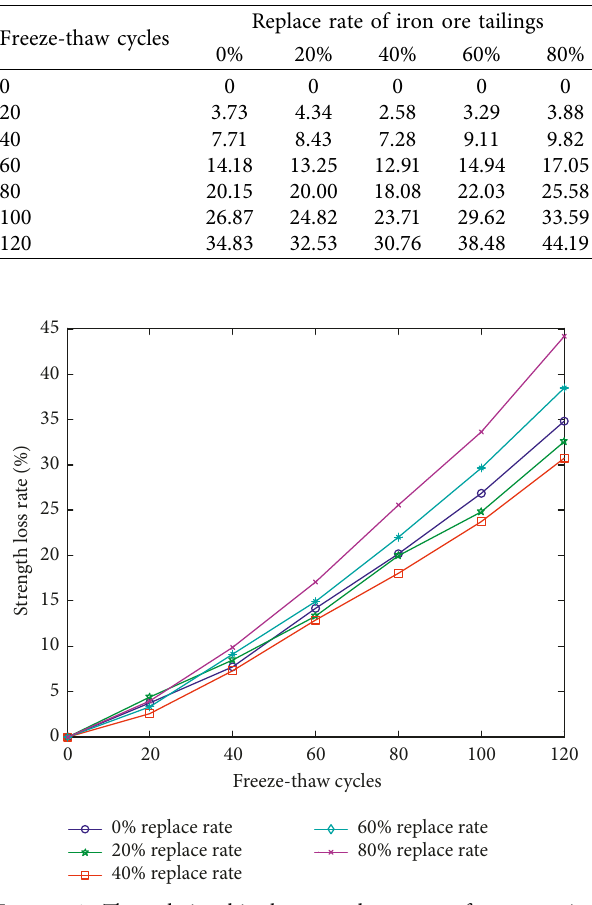
Figure 4: The relationship between loss rate of compressive strength and freeze-thaw